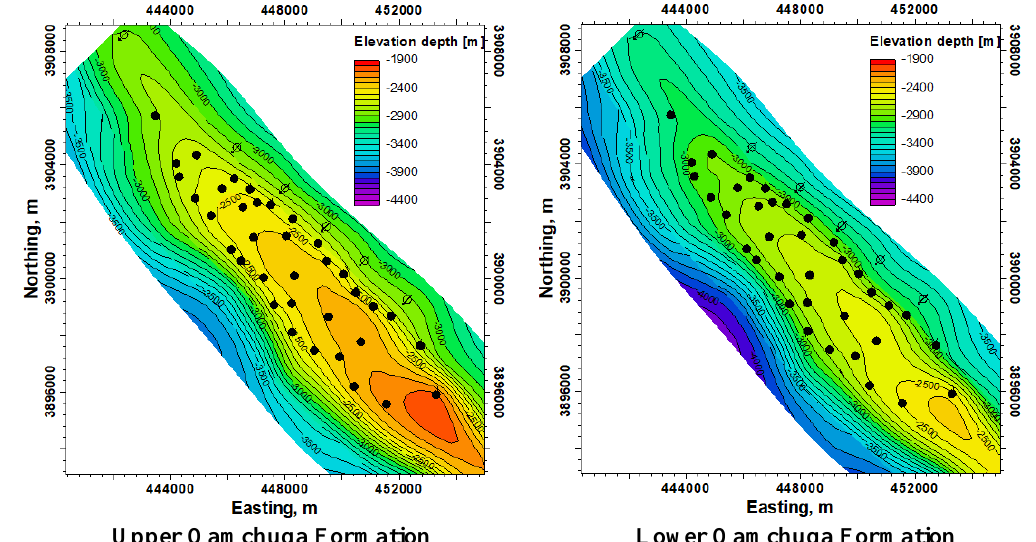
Figure 13. Contour maps of Upper and Lower Qamchuqa formations illustrates the northern region. The filled black dots refer to the drilled wells in the area, while the empty dots with an arrow indicate the proposed injection wells.